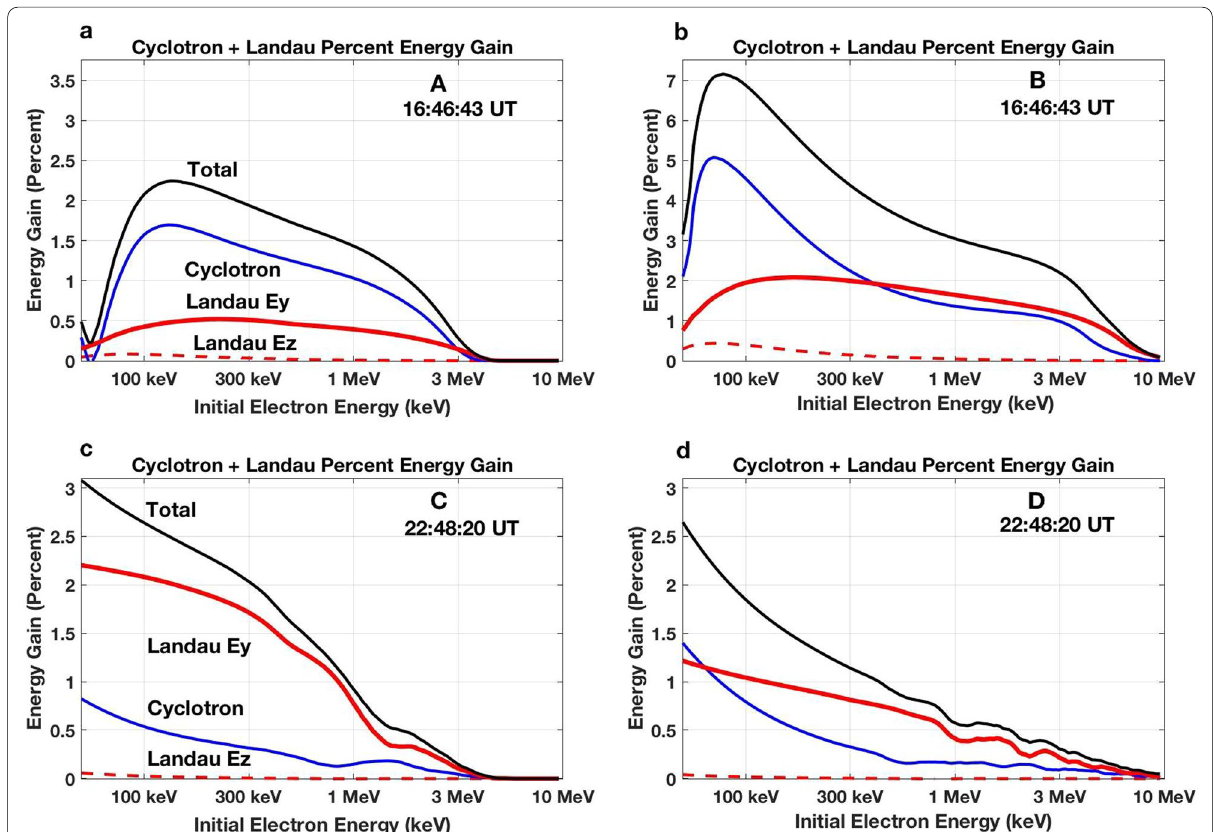
Fig. 6 For obliquely propagating chorus waves, the nonlinear Lorentz force of the perpendicular wave magnetic field results in effective electron acceleration. The percent energy gained by seed electrons in a resonant interaction with a single chorus subpacket is shown following the calculations of Omura et al. (2019). a – d Give the separate results for the initial (A and C) and 2nd strong (B and D) subpackets of the chorus elements described in Fig. 2d (A and B) and 4 (C and D). Percent energy gain through the perpendicular Landau ( n through cyclotron ( n 1) resonance in blue, with the total gain shown in =